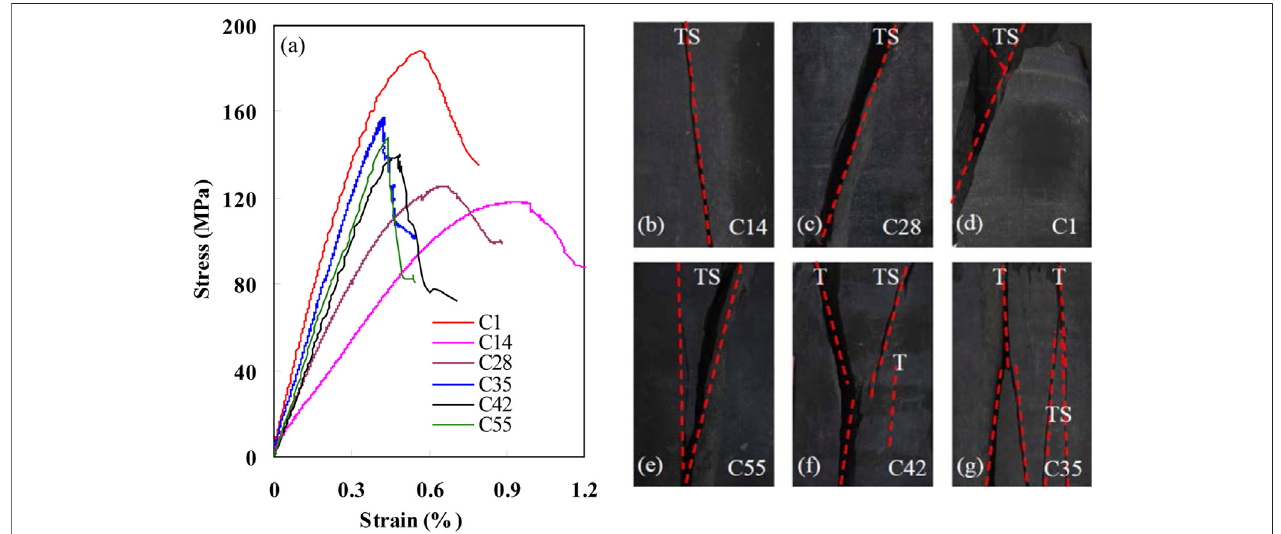
FIGURE 9 | Typical stress-strain curves of the shale samples (A) and fracture patterns (B – G) (T represents tensile crack and tensile shear crack in the fi gure).